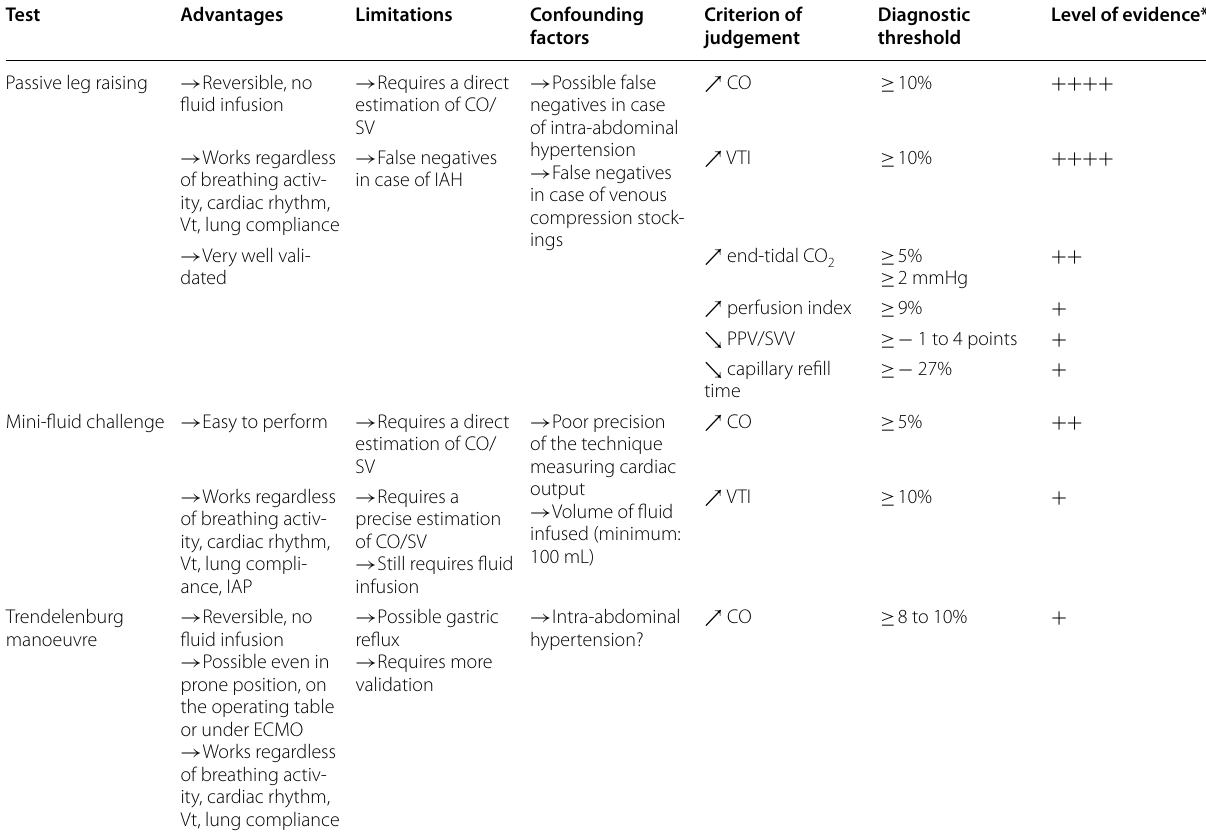
Table 1 Characteristics of tests assessing preload responsiveness by mimicking a classic fluid